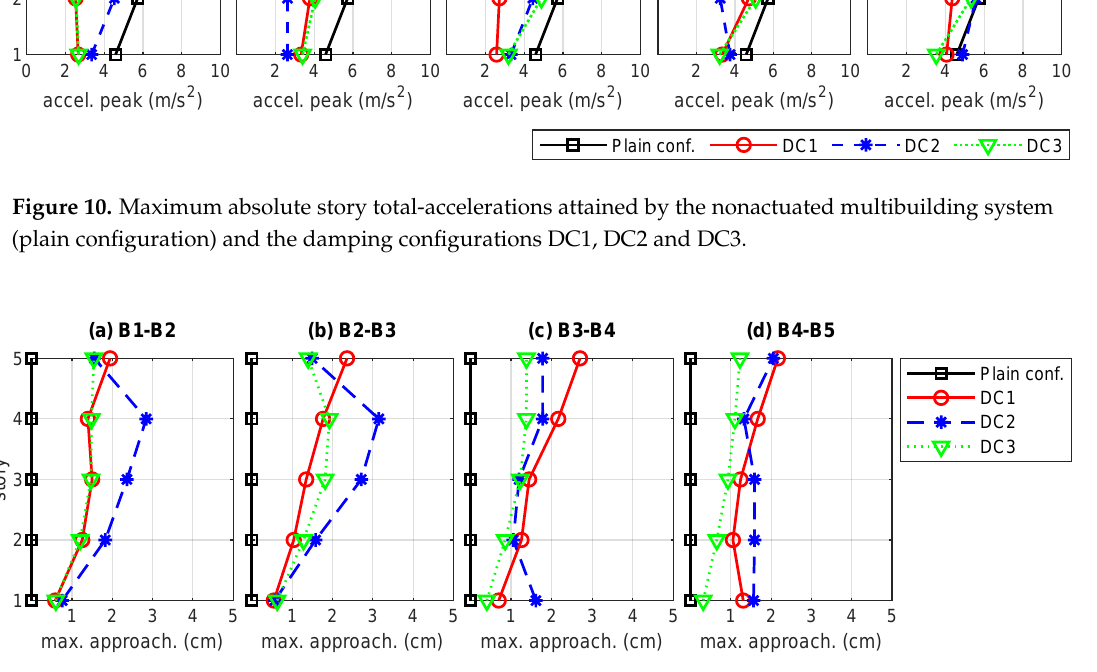
Figure 11. Maximum interbuilding approachings produced by the nonactuated multibuilding system (plain configuration) and the damping configurations DC1, DC2 and